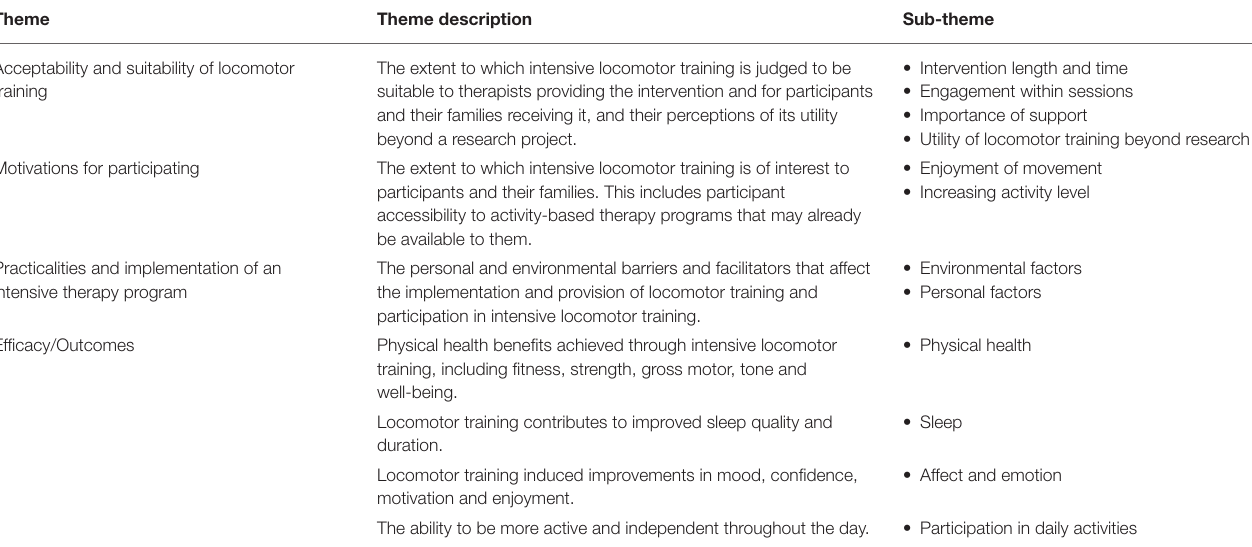
TABLE 3 | Feasibility and theme and sub-theme description.